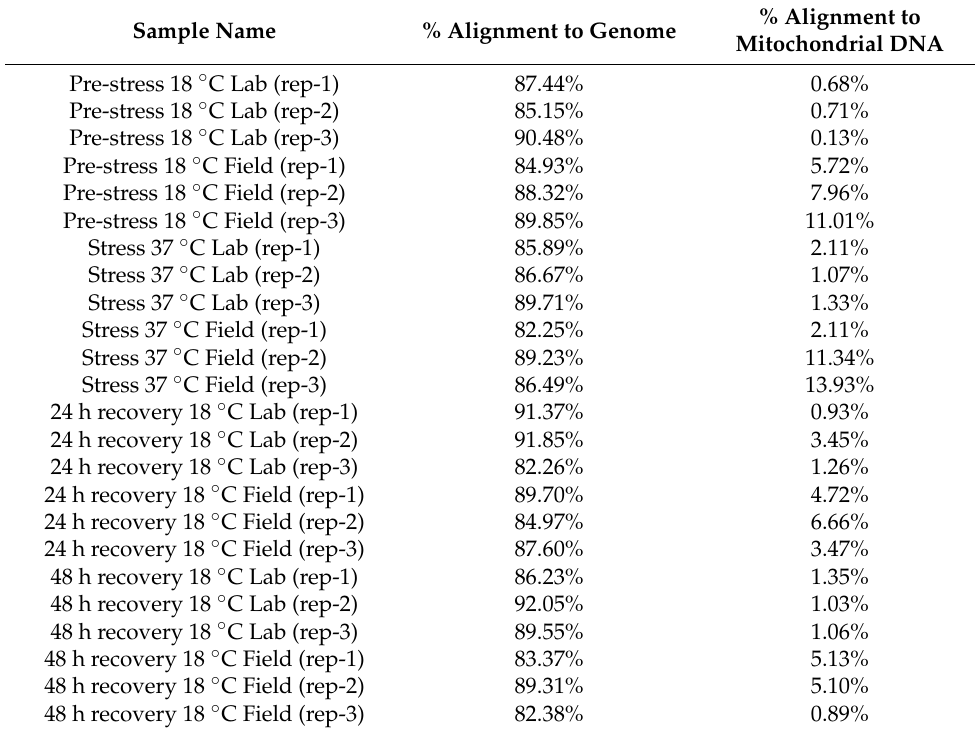
Table 1. Alignment rates of ATAC-seq reads from N. vectensis samples to the nuclear genome and mitochondrial